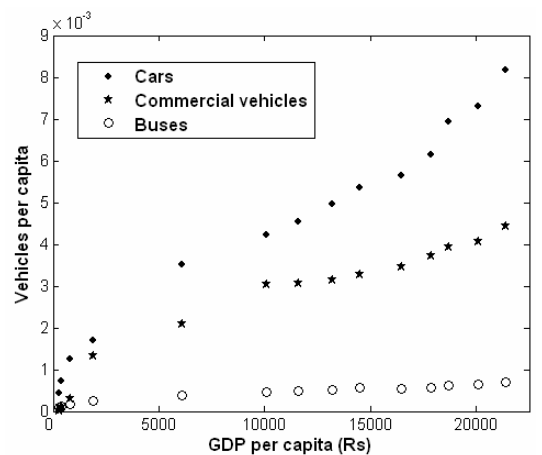
Fig 6. Variation of yearly vehicles per capita